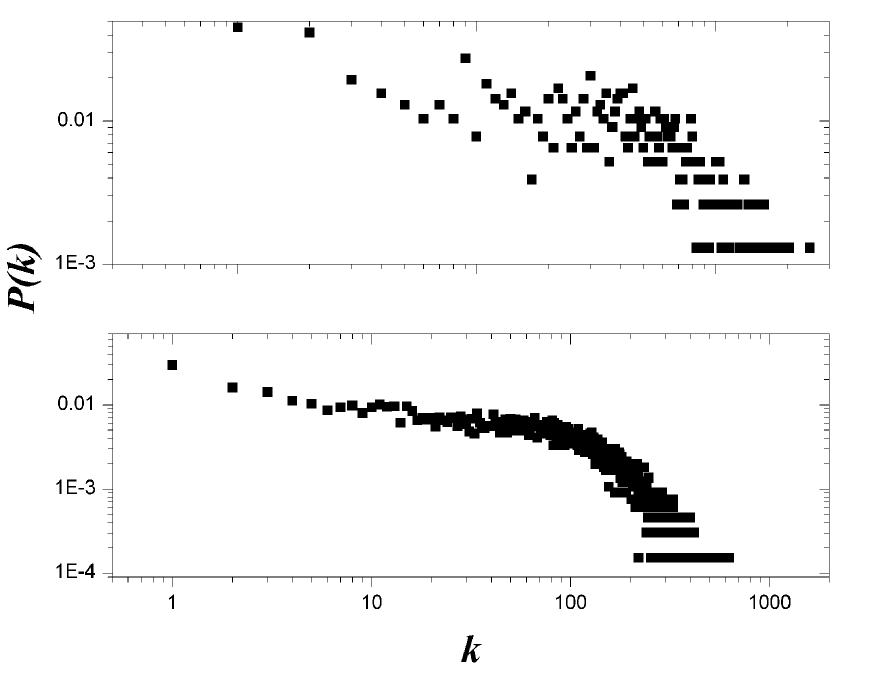
Figure 2. An illustration of degree distributions of the two social